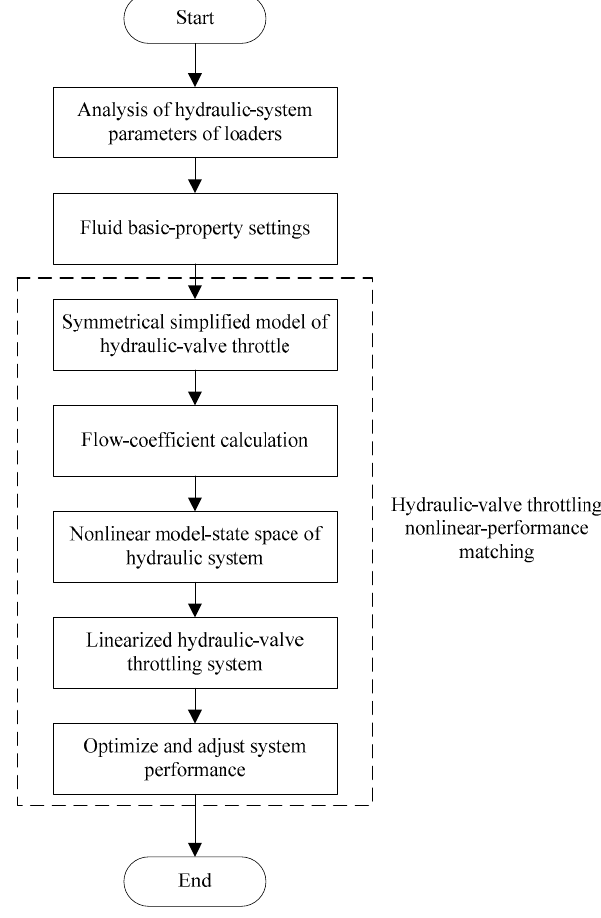
Figure 1. The frame diagram of the research content of this